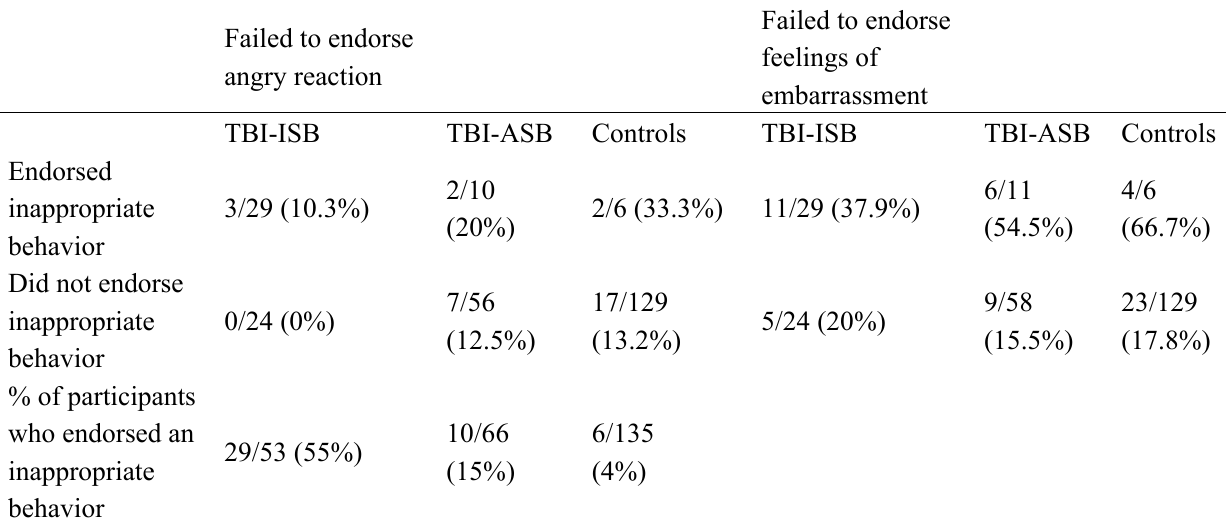
Table 4. Percentage (%) of participants by group who endorsed an inappropriate behavior (in Part A) and also failed to anticipate an angry reaction and/or feelings of personal embarrassment following the same behavior (in Part B), compared to the percentage of participants who did not endorse the inappropriate behavior and also failed to anticipate an angry reaction and/or feelings of embarrassment.